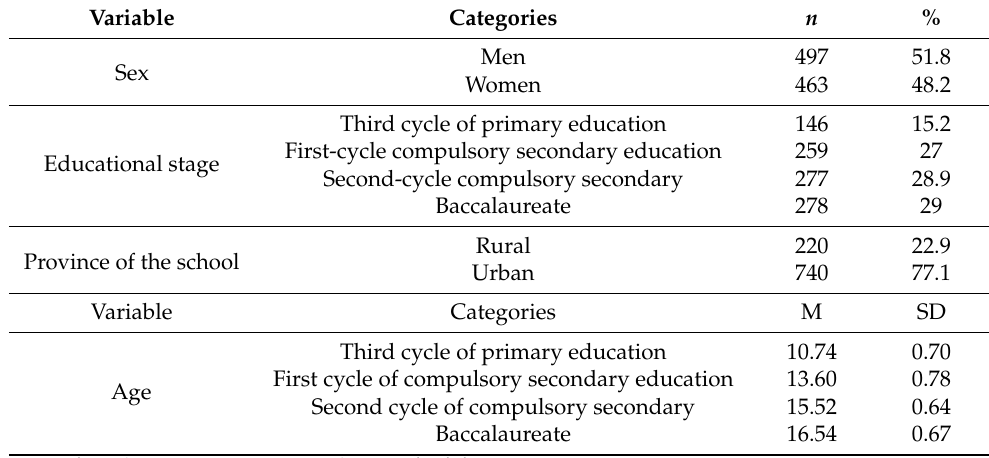
Table 1. Sample characterization (N = 960).